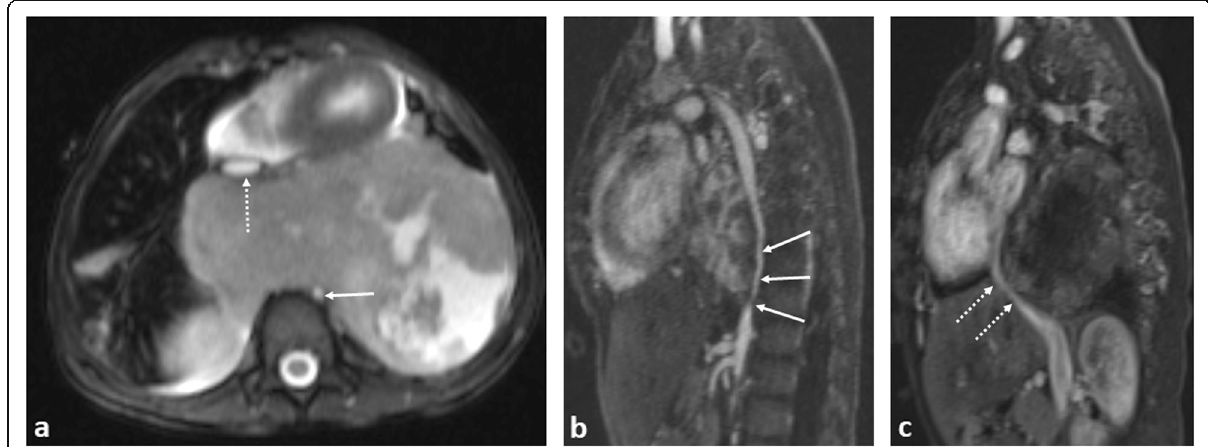
Fig. 21 Three-year-old boy with a large posterior mediastinal malignant nerve sheath tumour causing marked hypertension due to descending thoracic aortic compression. a Axial T2-weighted MRI image showing severe narrowing of the descending thoracic aorta (solid arrow) and anterior displacement of the IVC (dashed arrow). Sagittal post-contrast T1 images highlight the descending thoracic aortic ( b ) and upper abdominal IVC ( c ) compression, respectively. Due to the extensive nature of the mass, surgical resection was not through to be appropriate. The patient has subsequently undergone several cycles of chemotherapy and balloon dilatation of the thoracic aorta accompanied by a slow, but gradual improvement in symptoms and size of